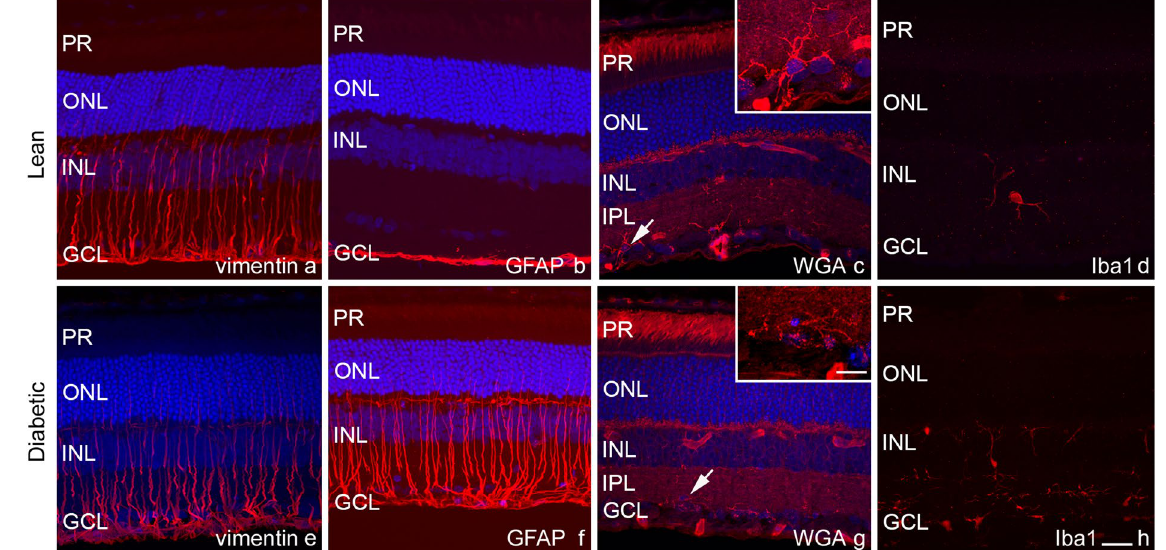
Figure 3. Glial responses in diabetes. Upper row shows control, lower row diabetic specimen. Müller glia cells were analysed using vimentin and GFAP antibodies. A marked increase in GFAP expression ( b , f ) but no major change in vimentin ( a , e ) labelling was evident. Microglia activation was analysed with WGA lectin and Iba1 antibody. Besides microglia cells WGA ( c , g ) labels the interphotoreceptor matrix of rods, blood vessels, and the plexiform layers. The microglia cells stained showed similar morphology (arrows on c and g, the same cells on high magnification on the insets). With Iba1 antibody ( d , h ) an approximately 2.5-fold increase in the number of microglia cells was detectable in diabetic specimen without evident signs of microglia activation. DAPI is used as a nuclear staining ( a – c and e – g in blue). PR: photoreceptor layer, ONL: outer nuclear layer, INL: inner nuclear layer, IPL: inner plexiform layer, GCL: ganglion cell layer. Bar : 20 μ m and 10 μ m for the